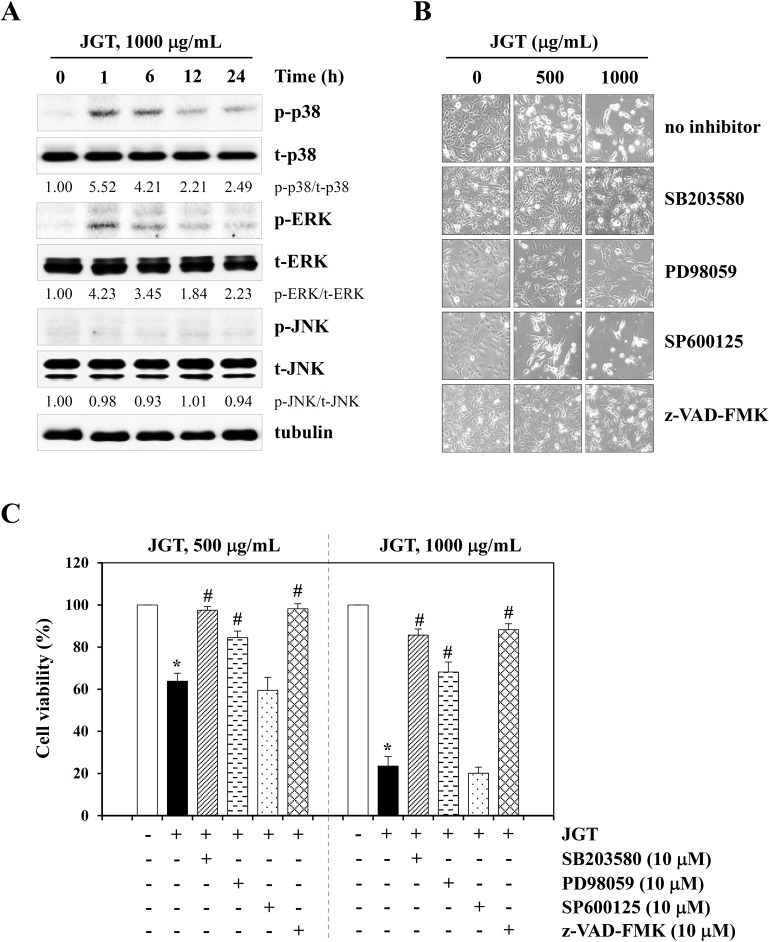
JGT induces cell death by activating p38 and ERK.
(A) Cells were treated with 1000 μg/mL JGT for 1, 6, 12, and 24 h, and the levels of total and phosphorylated MAPKs were measured by Western blotting. The band intensities relative to untreated cells were calculated after normalization to tubulin expression. Data are representative of three independent experiments. (B) After pre-treatment with or without specific inhibitors (10 μM), cells were treated with 500 and 1000 μg/mL JGT for 48 h, and observed under an inverted microscope. (C) The viability of cells in (B) was determined using MTT assays. Data are representative of three independent experiments performed in triplicate and are expressed as means ± SD. * p < 0.05 vs. untreated control, # p < 0.05 vs. no inhibitor.